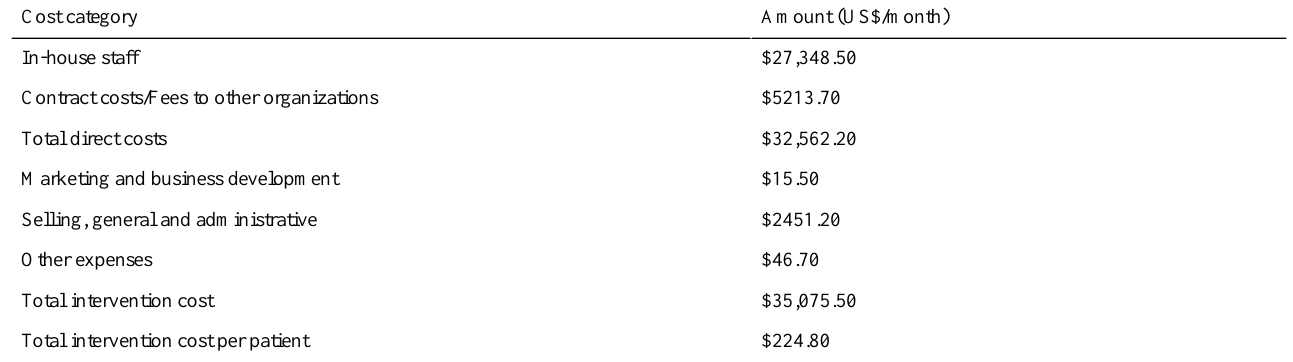
Table 4. Intervention cost (2011-2012).